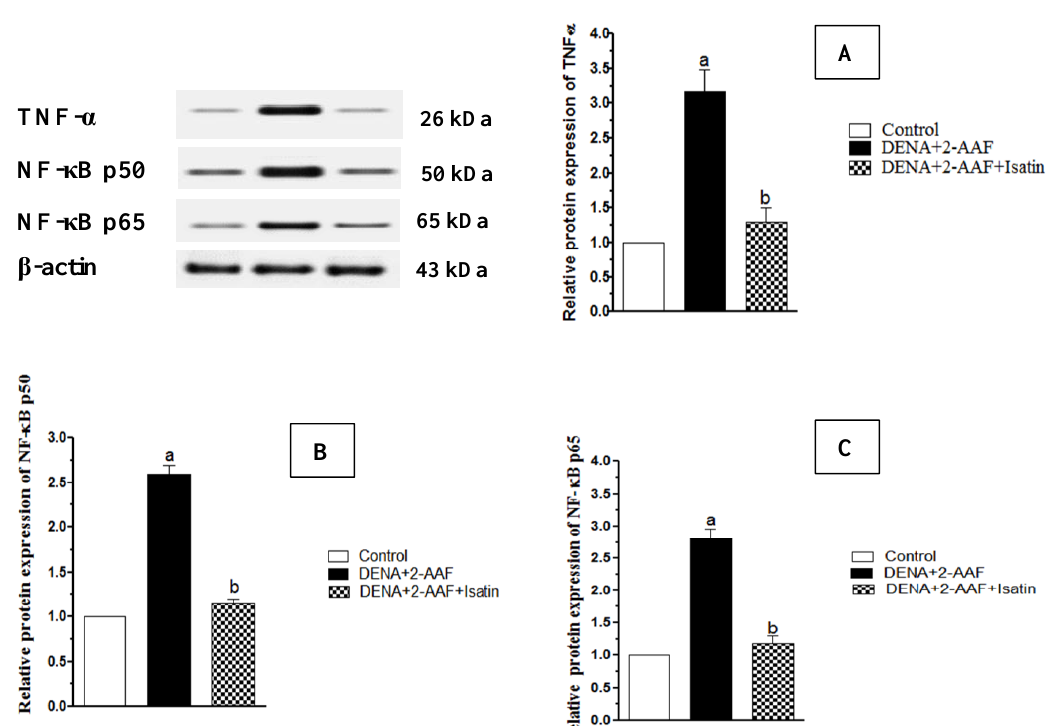
Figure 4. Isatin reversed DENA/2-AAF-induced upregulation of TNF- α ( A ), NF- κB p50 ( B ), and NF- κB p65 ( C ) protein expression in rat liver. Typical Western blots are shown (upper left panel). Data are presented as mean ± SEM. a p < 0.05 vs. control group. b p < 0.05 vs. DENA/2-AAF group.